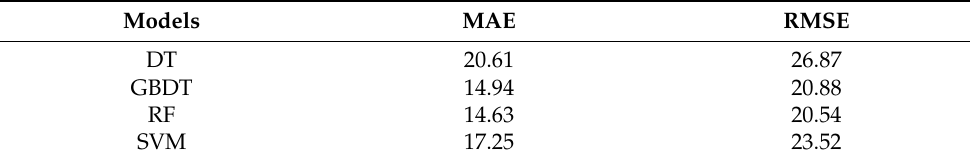
Table 3. Results of the various machine learning algorithms on the training set.